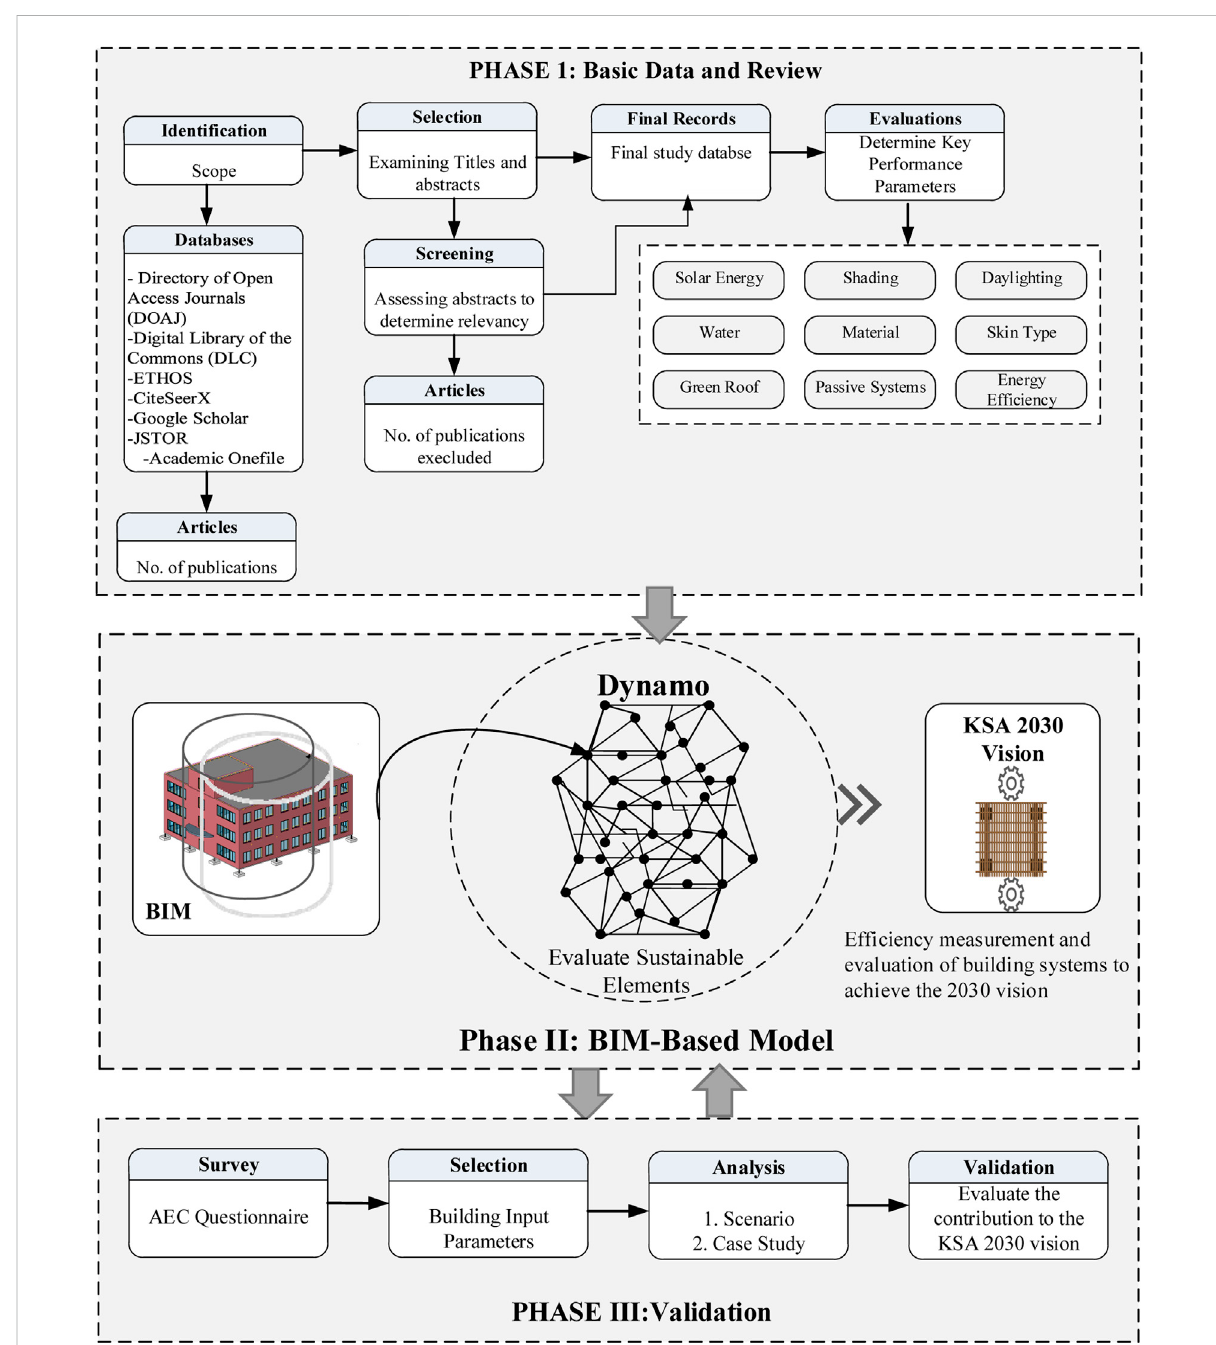
FIGURE 5 Overview of the research methodology